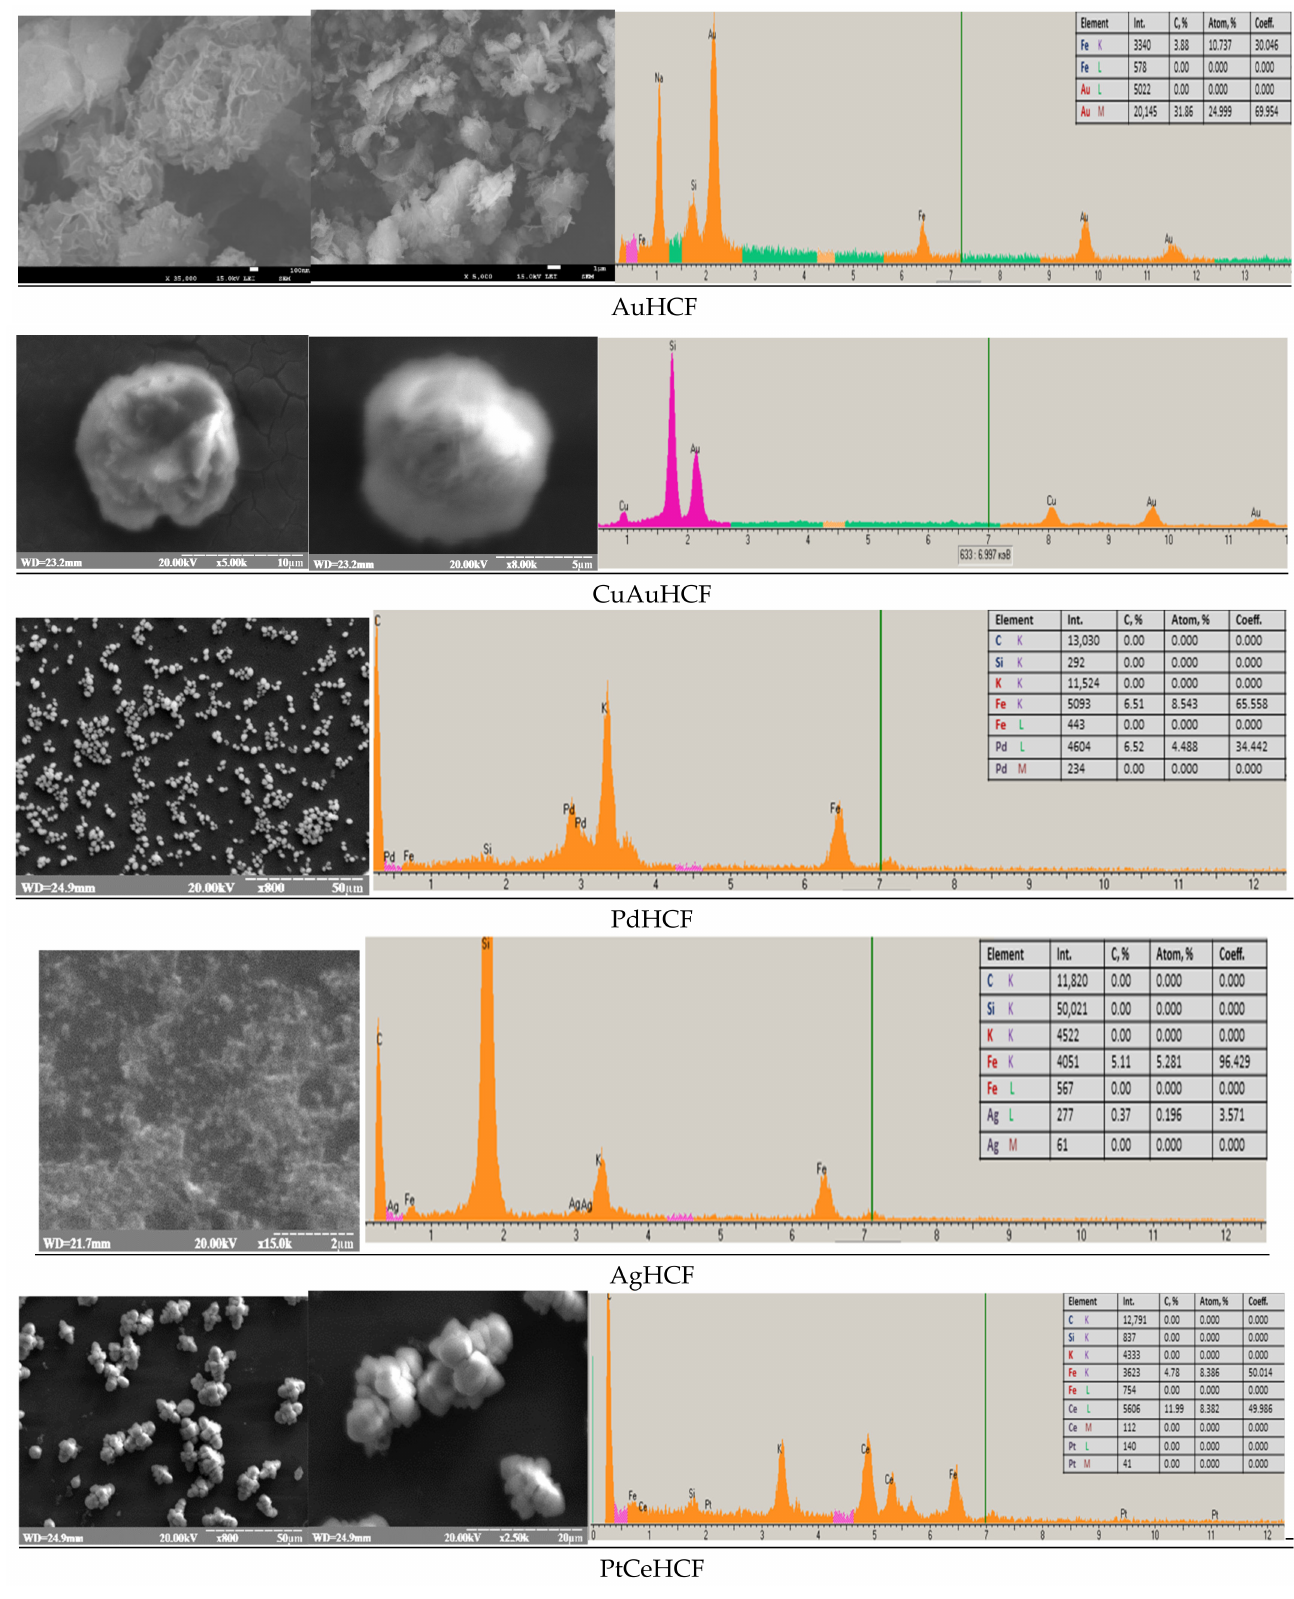
Figure A4. Structural and morphological characterizations of the synthesized NPs. The SEM ( left column ) with XRM (right column ) images of